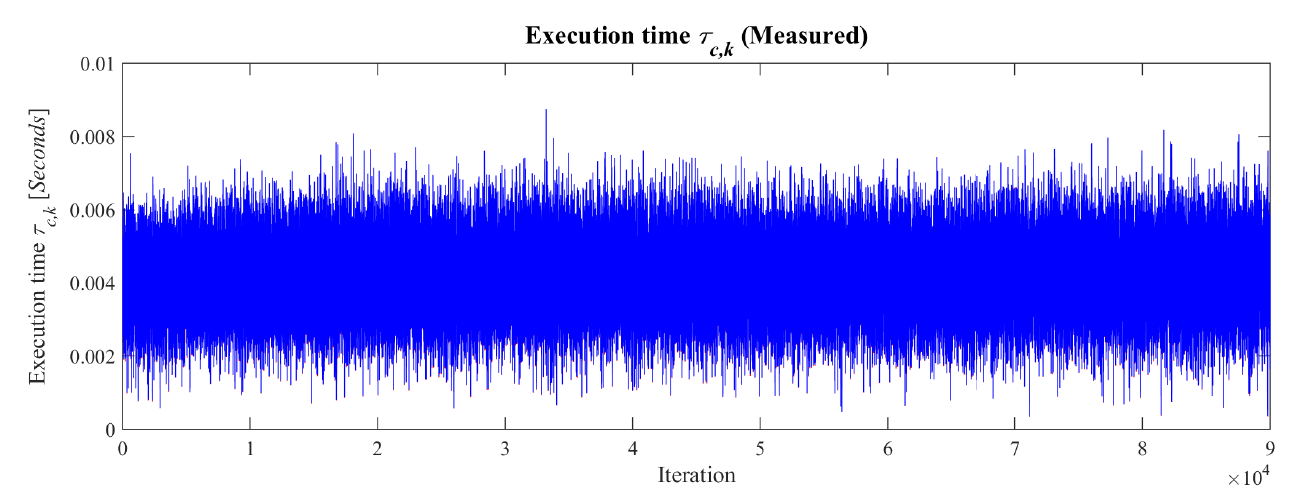
Figure 9. Execution times τ c , k measured in Client